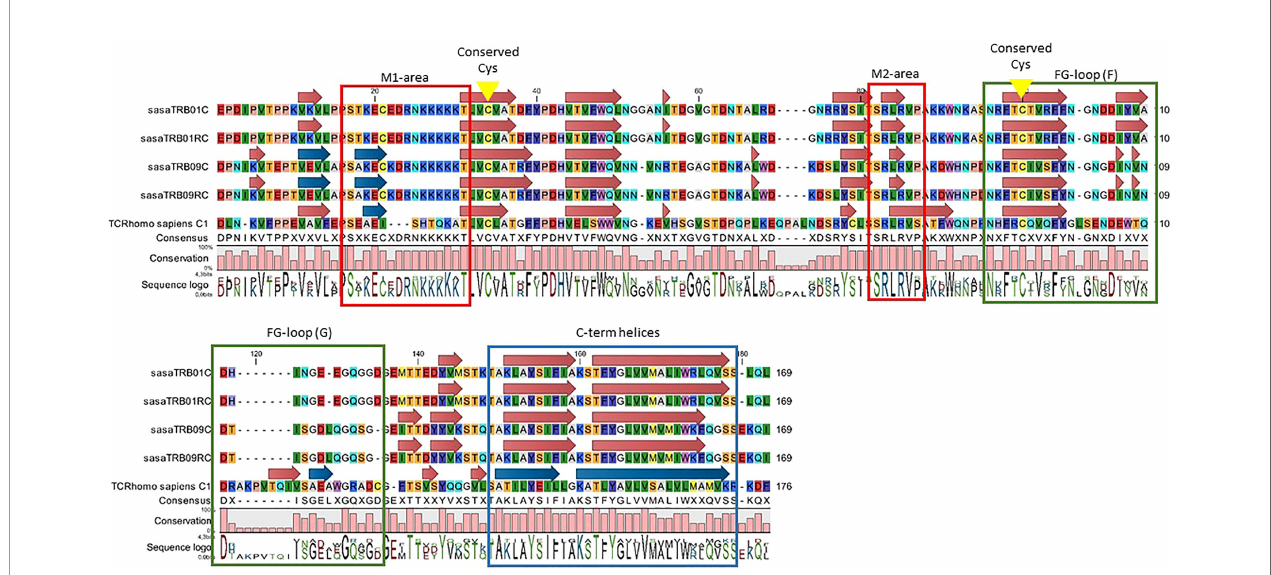
FIGURE 2 | Alignment of deduced amino acid sequences from the TRBC regions from Atlantic salmon (TRB01C, TRB01RC, TRB09C, TRB09RC) with human TRBC1 (Ensembl ID ENST00000633705.1). Boxes denote regions with reported functions in signalling triggered by peptide-MHC complexes. Motifs M1 and M2 (red frames) reported in (47), FG loop (green frames) functions (48), and C-terminal helices (blue arrows and frame). Conserved cysteines are marked by yellow